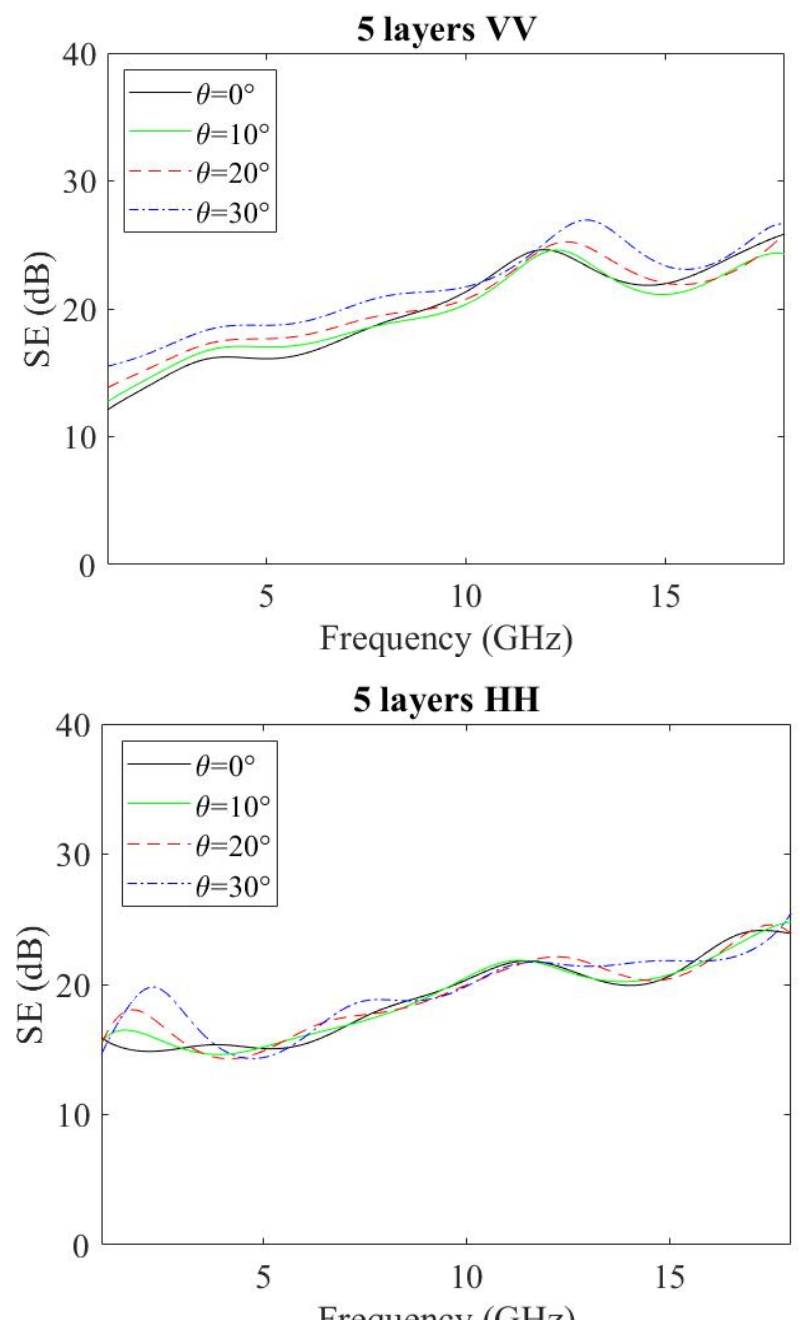
Figure 9. Plots of the SE versus frequency of a sample with 5-layer biochar coating for different angles of incidence. Vertical polarization ( top panel ). Horizontal polarization ( bottom panel ).